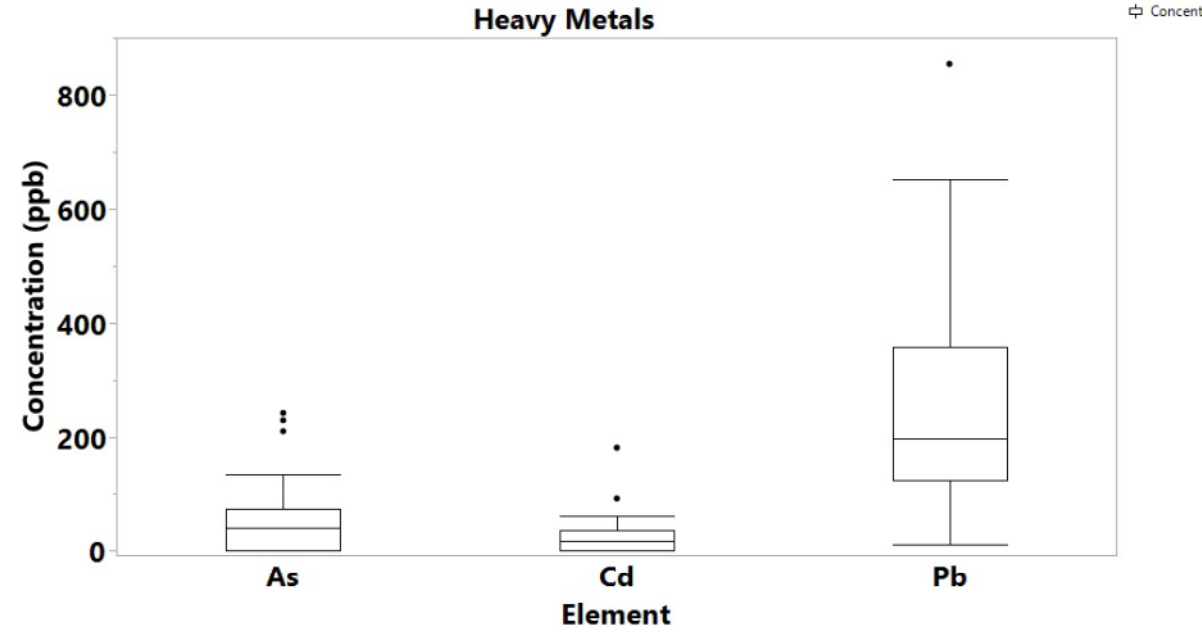
Figure 3. Box plot of toxic metals/metalloids concentration in cannabis samples.